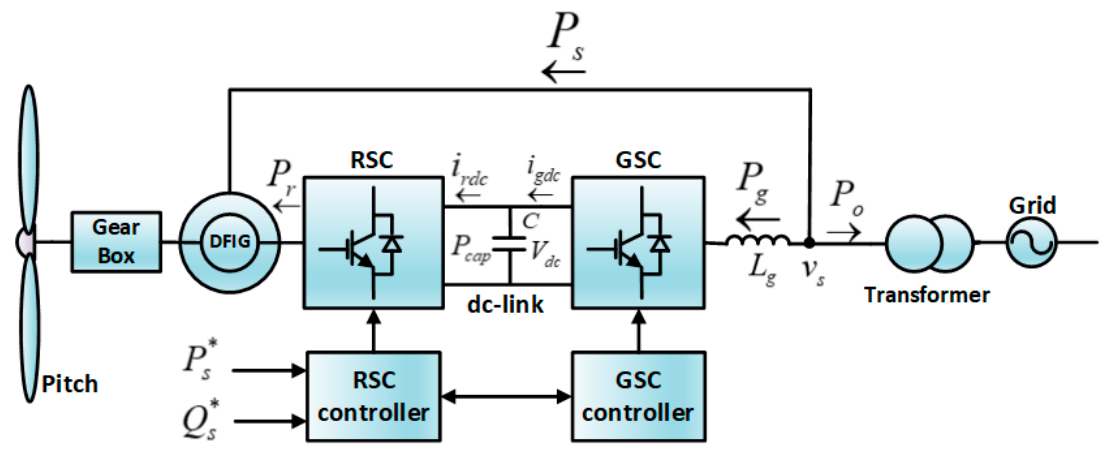
Figure 1. Active power flow in a DFIG wind turbine.